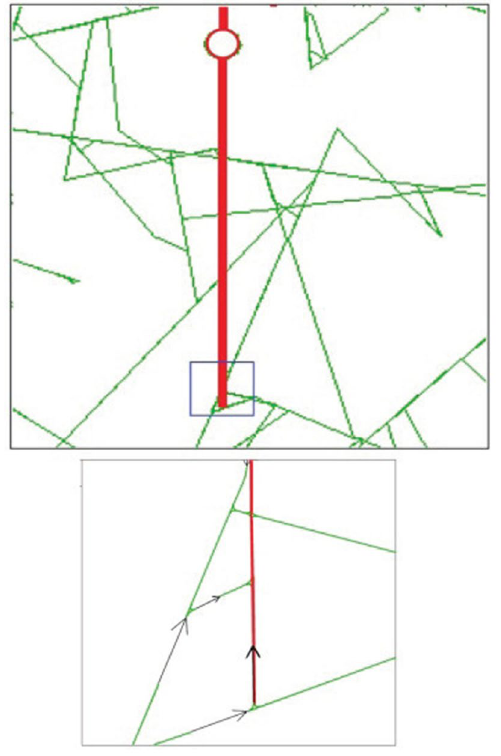
Fig. 18 Current status in a section of the hydraulic fracture of 14 m in